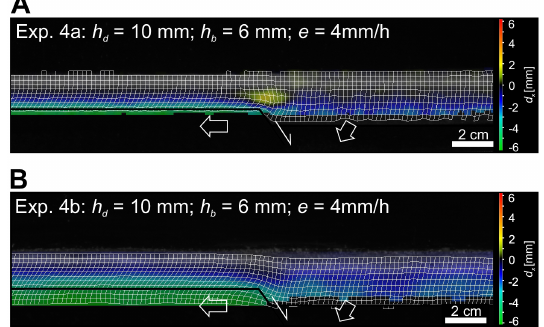
Figure 12. Comparison of two experiments with equal initial con- ditions, but (a) without syn-extensional sand accumulation and (b) with syn-extensional sand accumulation in the hanging wall peripheral sink. Downward flow is prevented in (b) . However, no upward flow can be recognized in (b) , although differential load- ing between the hanging wall side and the footwall side is present. Coloured areas display rightward (yellow–red) and leftward (green– blue) movement of the analogue